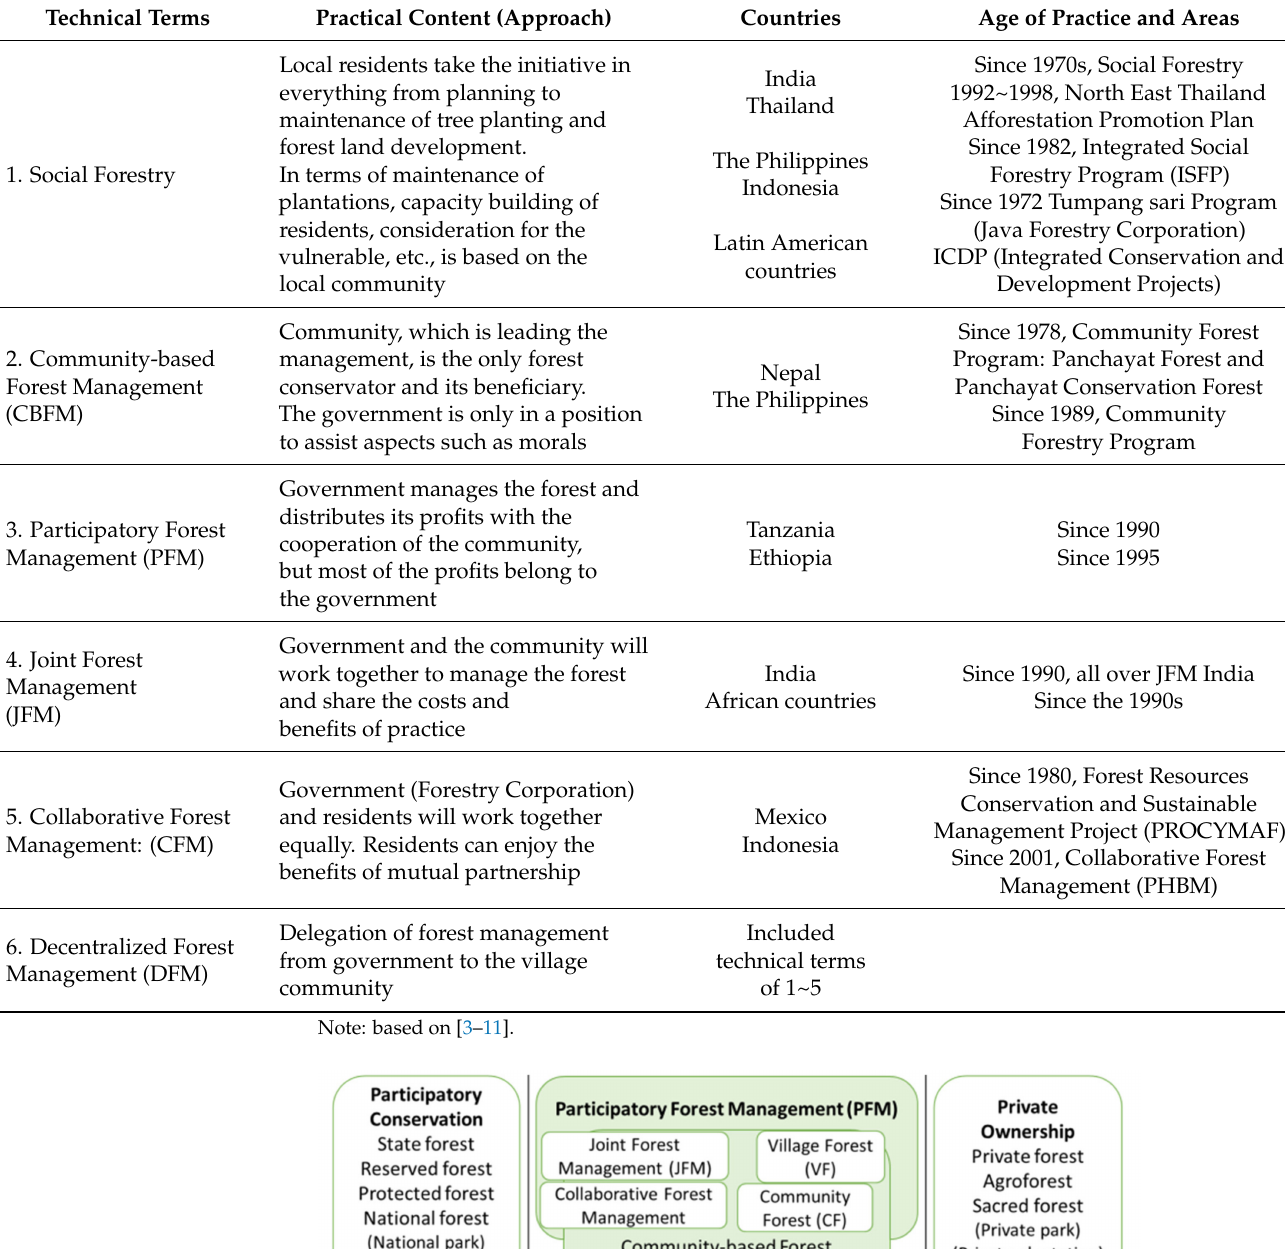
Table 1. Comparison of the practical contents of participatory forest management.